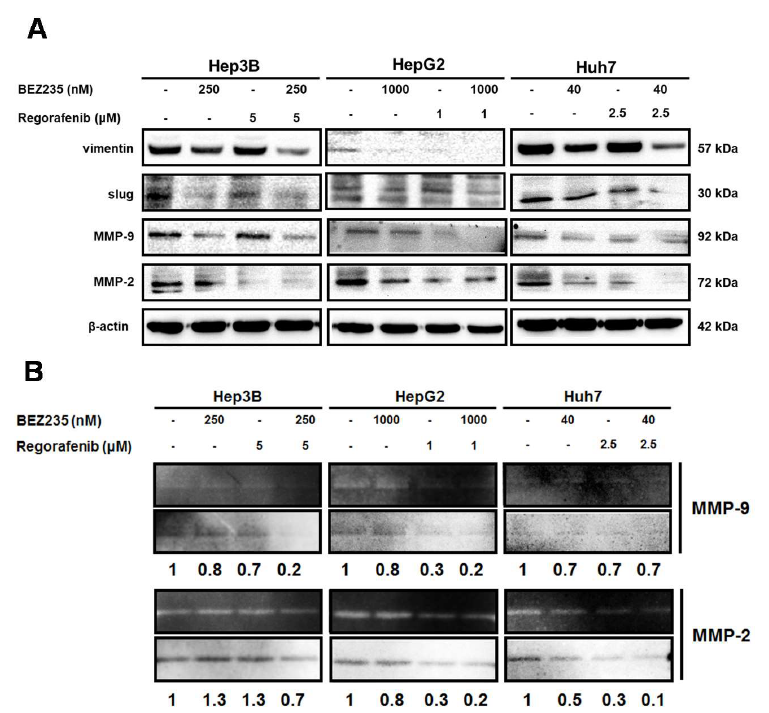
Figure 4. EMT-associated proteins are down-regulated upon combinatorial treatment in HCC cells. The expression pattern of the EMT-associated proteins was analyzed using Western blot ( A ), while the enzymatic activity of MMP-9/-2 were checked using zymography ( B ), following combined treatment of the HCC cells.